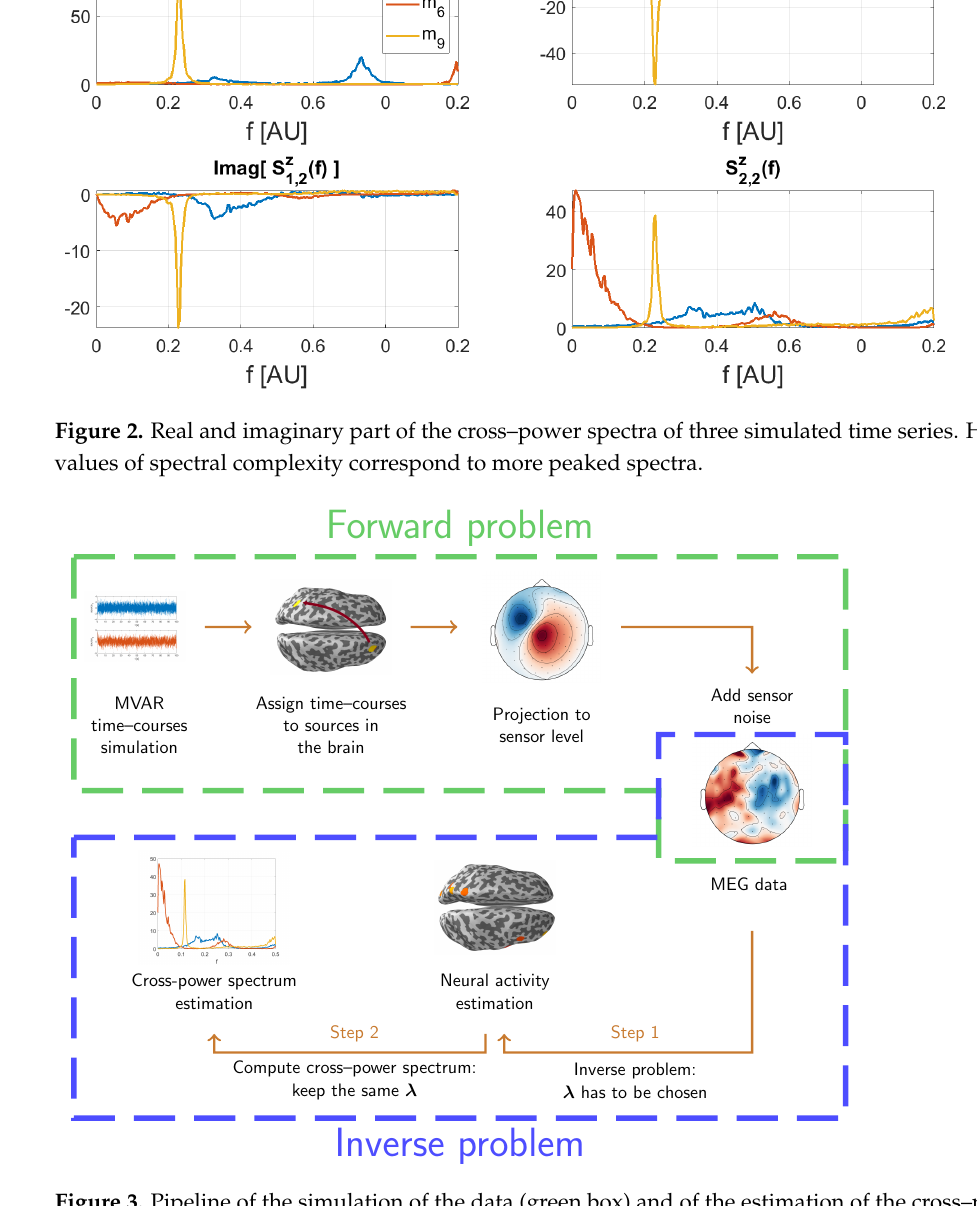
Figure 3. Pipeline of the simulation of the data (green box) and of the estimation of the cross–power spectrum (blue